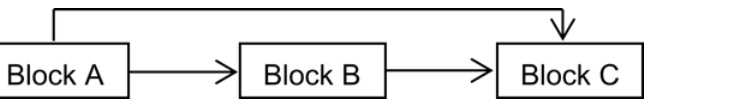
Fig 1. Model of the block structure of the chain graph model used in the study. Block A: age and sex. Block B: the 19 somatic symptoms in a interrelated system. Block C: self-perceived health or limitations due to physical